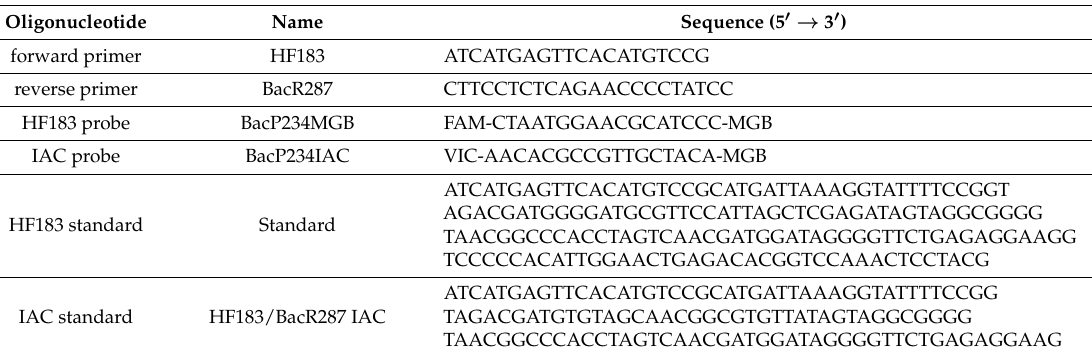
Table A1. Sequences of primers, probes and standards